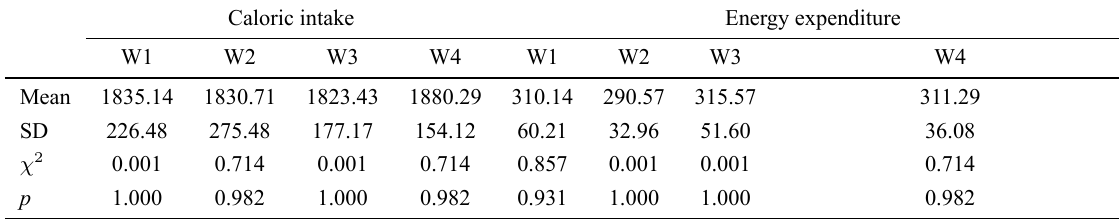
Fig. 2. Correct elbow plank postures. Table 1. Calorie intake and calorie out every week of the participant. Caloric intake Energy expenditure